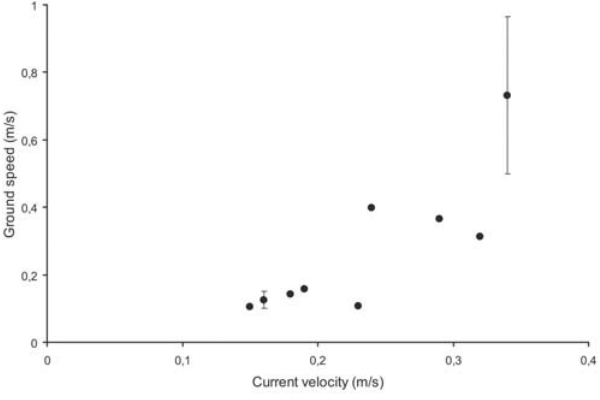
Figure 3. Ground-speed measures of roach moving upstream at different current velocities. Error bars indicate SD on days with more than one upstream migration.